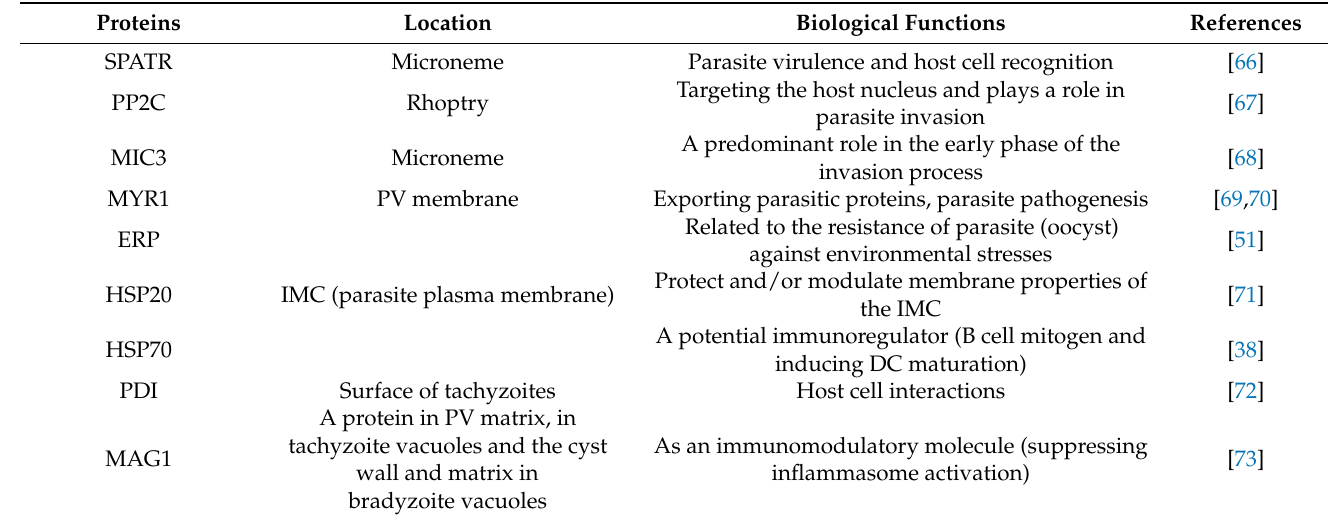
Figure 1. Proteomic techniques mainly used for the identification of T. gondii proteome.